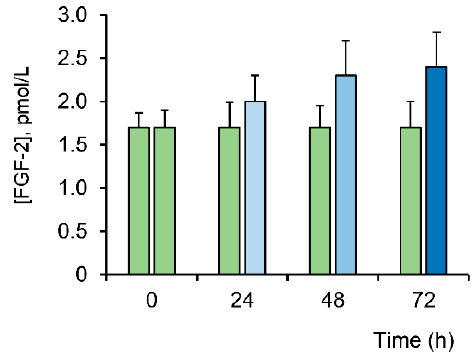
Figure 7. Evaluation of the fibroblast growth factor (FGFb) level in BMSC at different times after LTP exposure (blue bars). Data are represented as the means ± SEM ( n = 3). The green bars indicate no exposure to plasma.